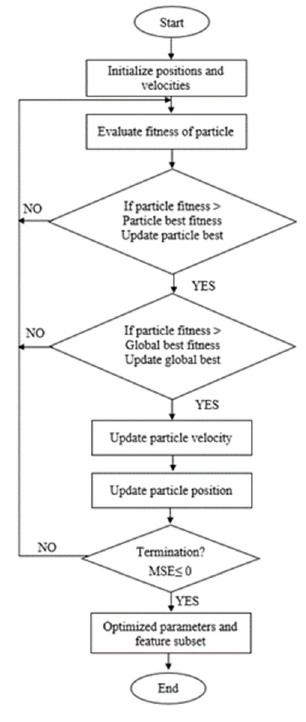
Figure 6. Flow of PSO optimization.